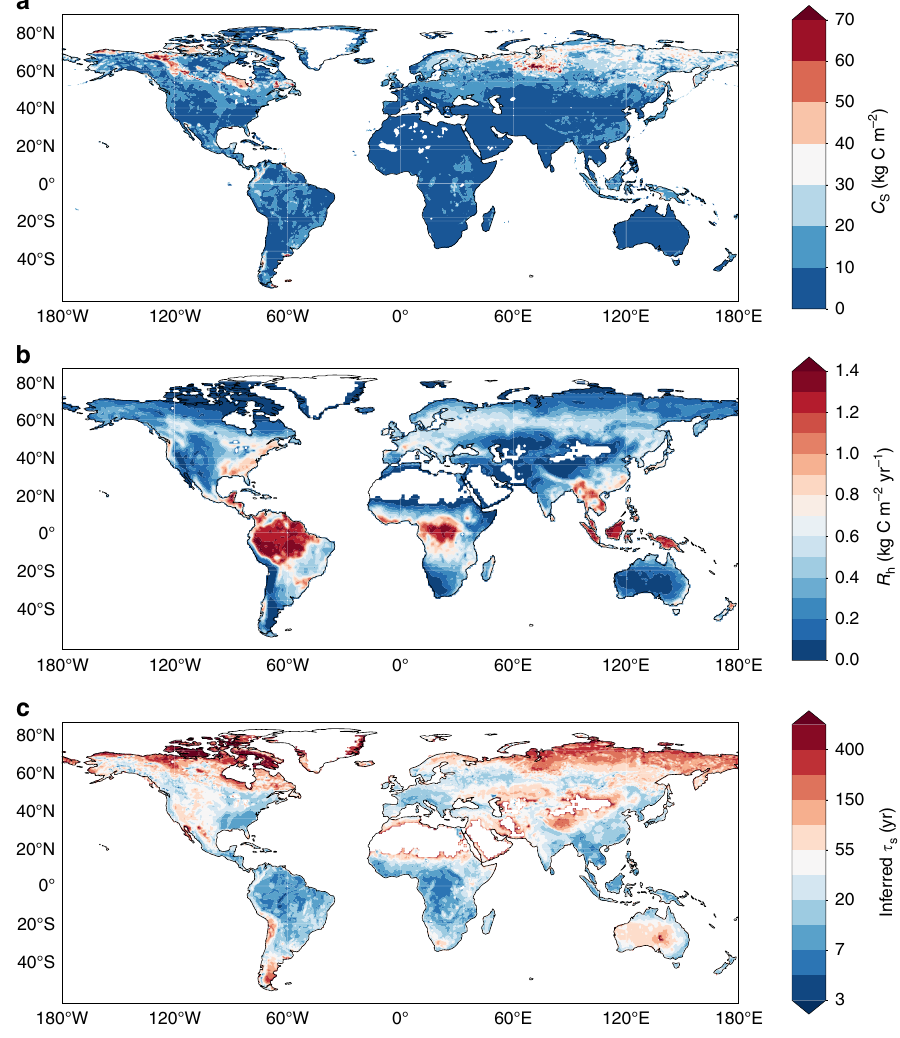
Fig. 2 Spatial variability of soil carbon turnover time inferred from observations. Maps of a observed soil carbon ( C s ) to a depth of 1 m (kg C m − 2 ) 19,20 , b observed heterotrophic respiration ( R h,0 ) (kg C m − 2 yr − 1 ) 21 , and c inferred soil carbon turnover time (log τ s )